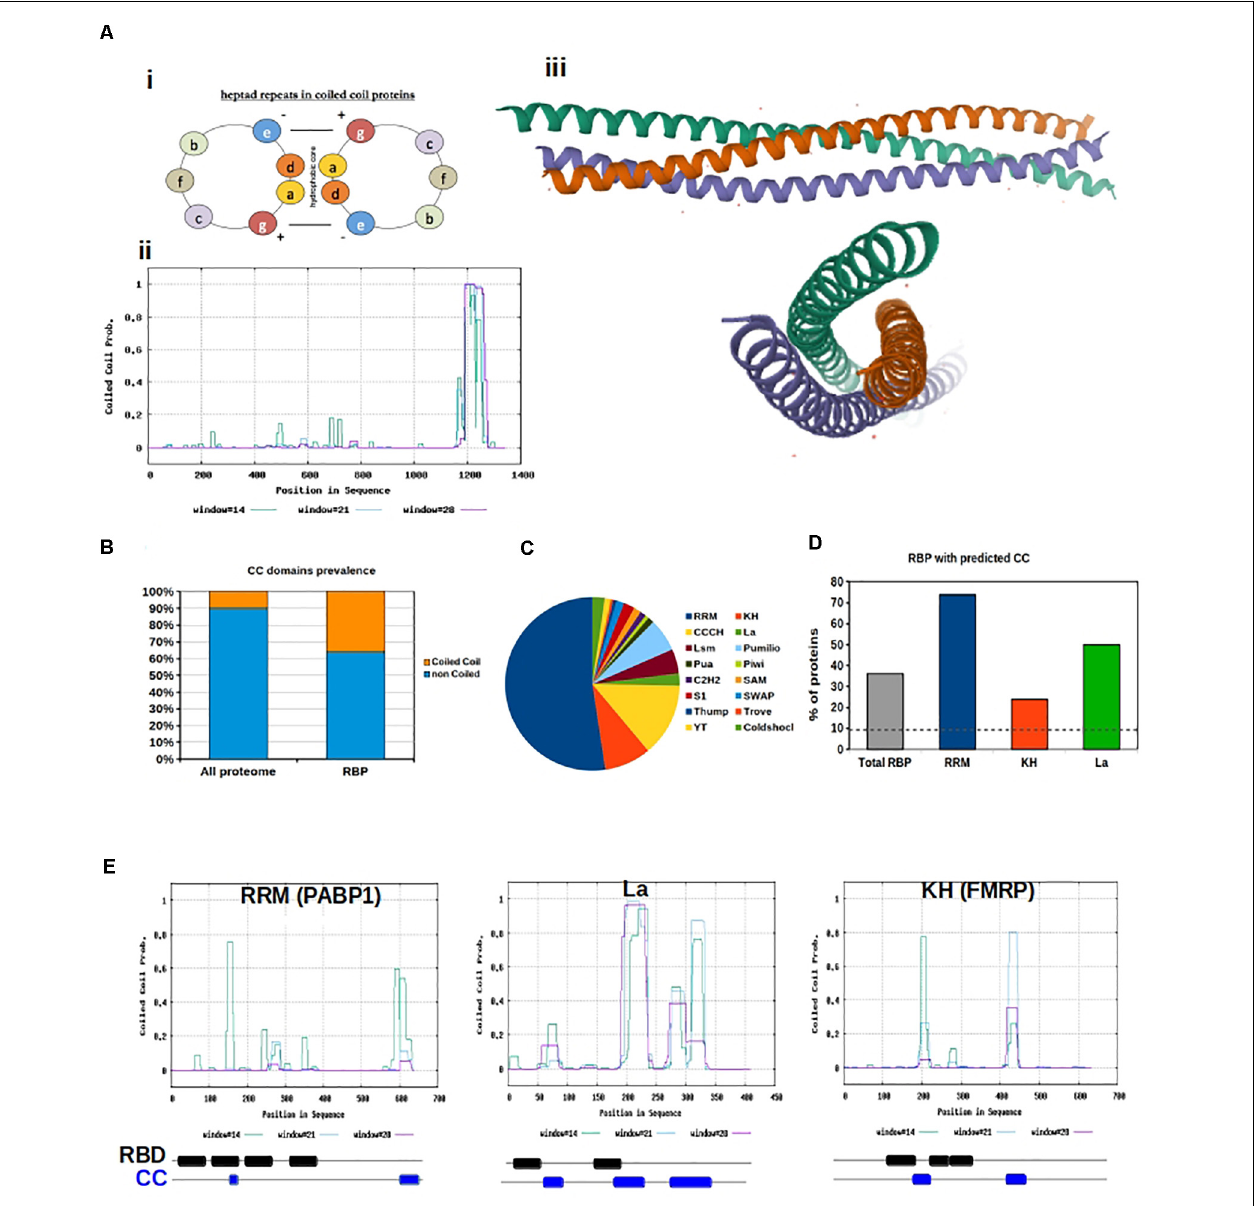
FIGURE 1 | Coiled coils motifs in RNA Binding proteins. (A) (i) Helical wheel projection showing the position of amino acids in heptad repeats. (ii) Prediction of coiled coil motifs in SynGAP. The probability of coiled coil is plotted for each amino acid using the Software Paircoils. The three different colors correspond to the probability of assuming the coiled fold depending on the length of the amino acid sequence. (iii) Graphic representation of the Crystal structure of SynGAP coiled coil domain; (B) Prevalence of proteins with CC motifs in the eukaryotic proteome vs presence of CC in RBP. The software Coils was used to predict the presence of CC in RBP listed in the database RBPDB; (C) Pie chart representation of the abundance of different RNA binding domains in RBPs. RRM are the most abundant; (D) The graph shows the percentage of RBPs with Coiled coils motifs, based on the type of RNA binding domain; (E) Graphical representation of coiled coil prediction for PABP1, La and FMRP. Below each graph a schematic of the organization of the RNA binding domains (RBD, black) and CC motifs (blue) is shown. RBD and CC are justaxposed, with minimal or no